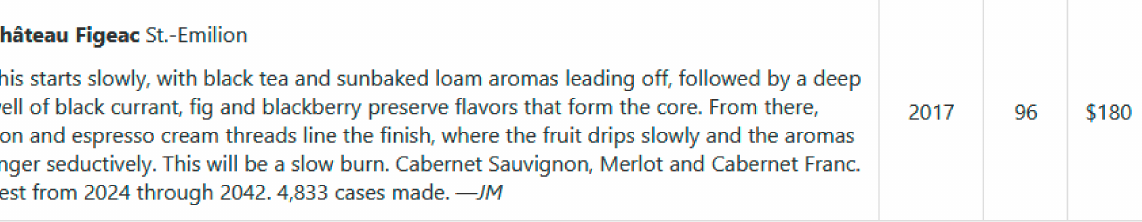
Figure 1. An example of wine reviews on WineSpectator.com. Due to the changing monetary values of wines over time, price values are not considered in the filtering or clustering